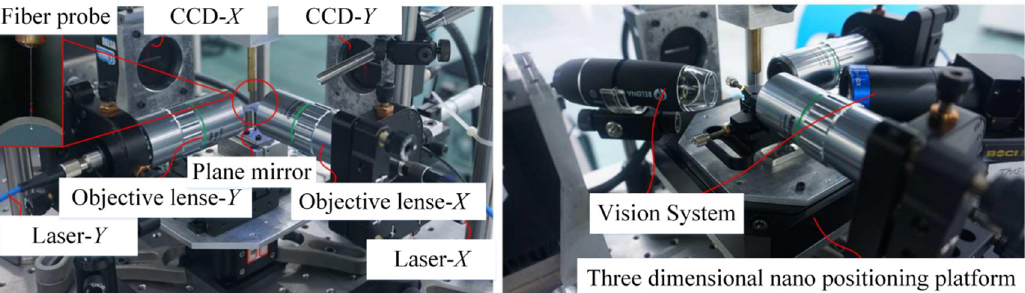
Figure 3. Experimental setup of the fiber probe. Table 1. Geometric dimension of nozzles measured by the optical fiber probe